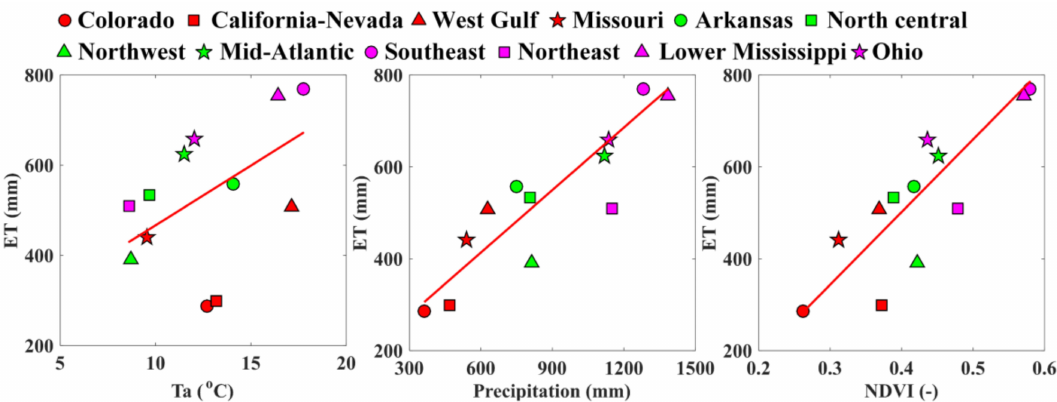
Figure 8. Plots of 30-year-averaged evapotranspiration (ET) against air temperature (Ta), precipitation ( P ), and normalized di ff erential vegetation index (NDVI) over the 12 river forecast centers (RFCs). The red line represents the fitted linear regression.